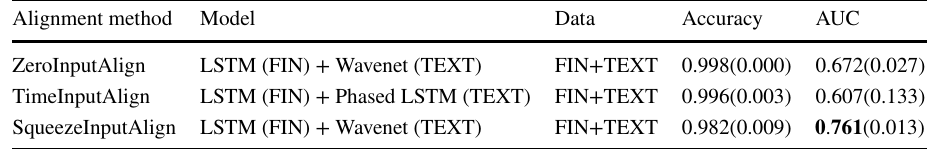
Table 4 The results of different alignment